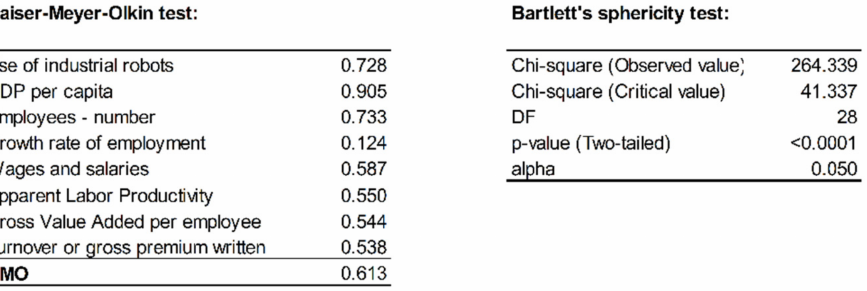
Figure 10. KMO test and Bartlett’s sphericity test. Source: Author’s contribution based on data retrieved from Eurostat. Annual enterprise statistics for special aggregates of